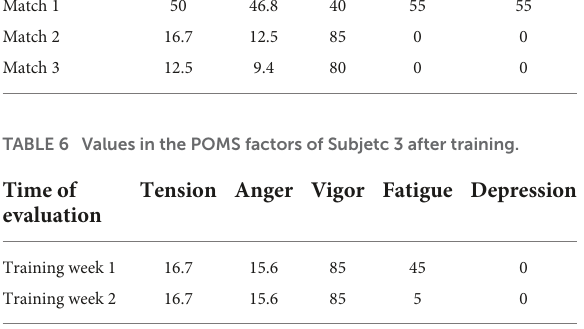
TABLE 5 Values in the POMS factors of Subject 3 after the matches. Time of evaluation